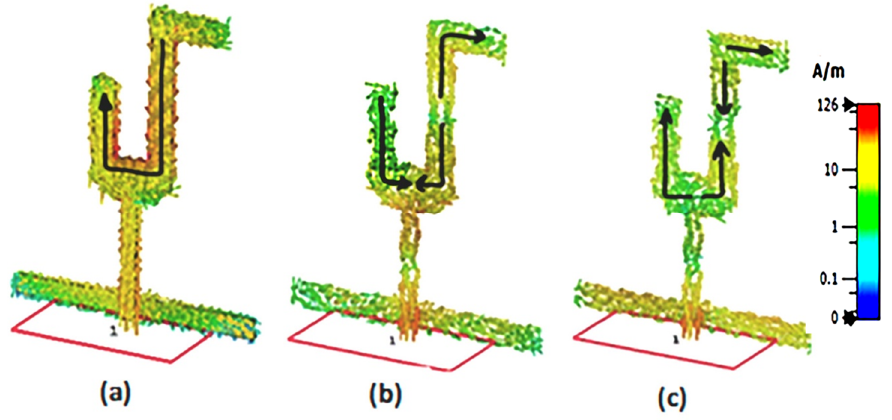
Figure 12. Surface current distribution at resonating frequencies of ( a ) 2.45 GHz, ( b ) 5.8 GHz, ( c ) 8.0 GHz.